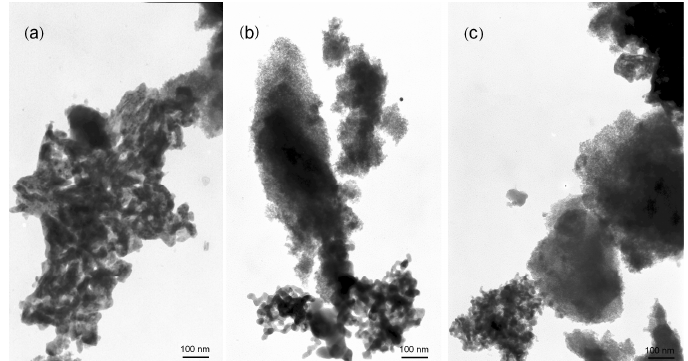
Figure 4. TEM micrographs of sol-gel calcined samples at the Ca/Si molar ratio: ( a ) 0.25; ( b ) 0.5; ( c ) 1.0.